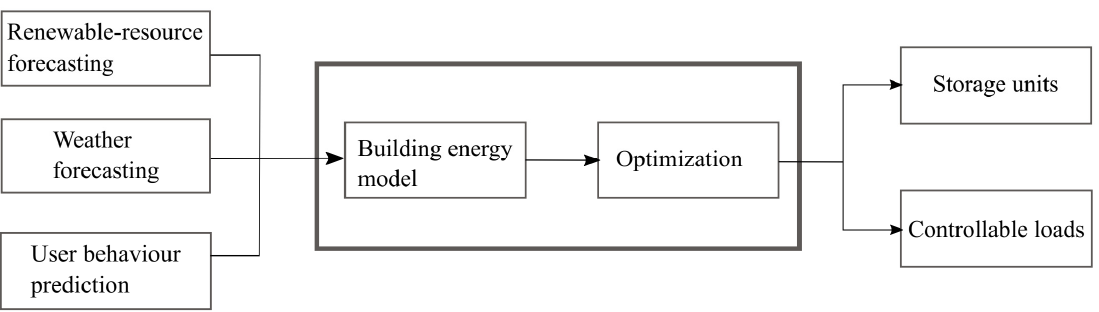
Figure 2. Schematic of energy efficiency management and role of monitoring platform.